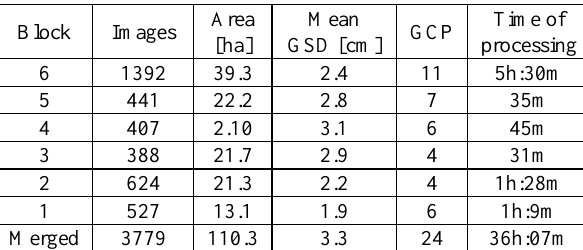
Table 3. Blocks characteristics for Nea Paphos site.